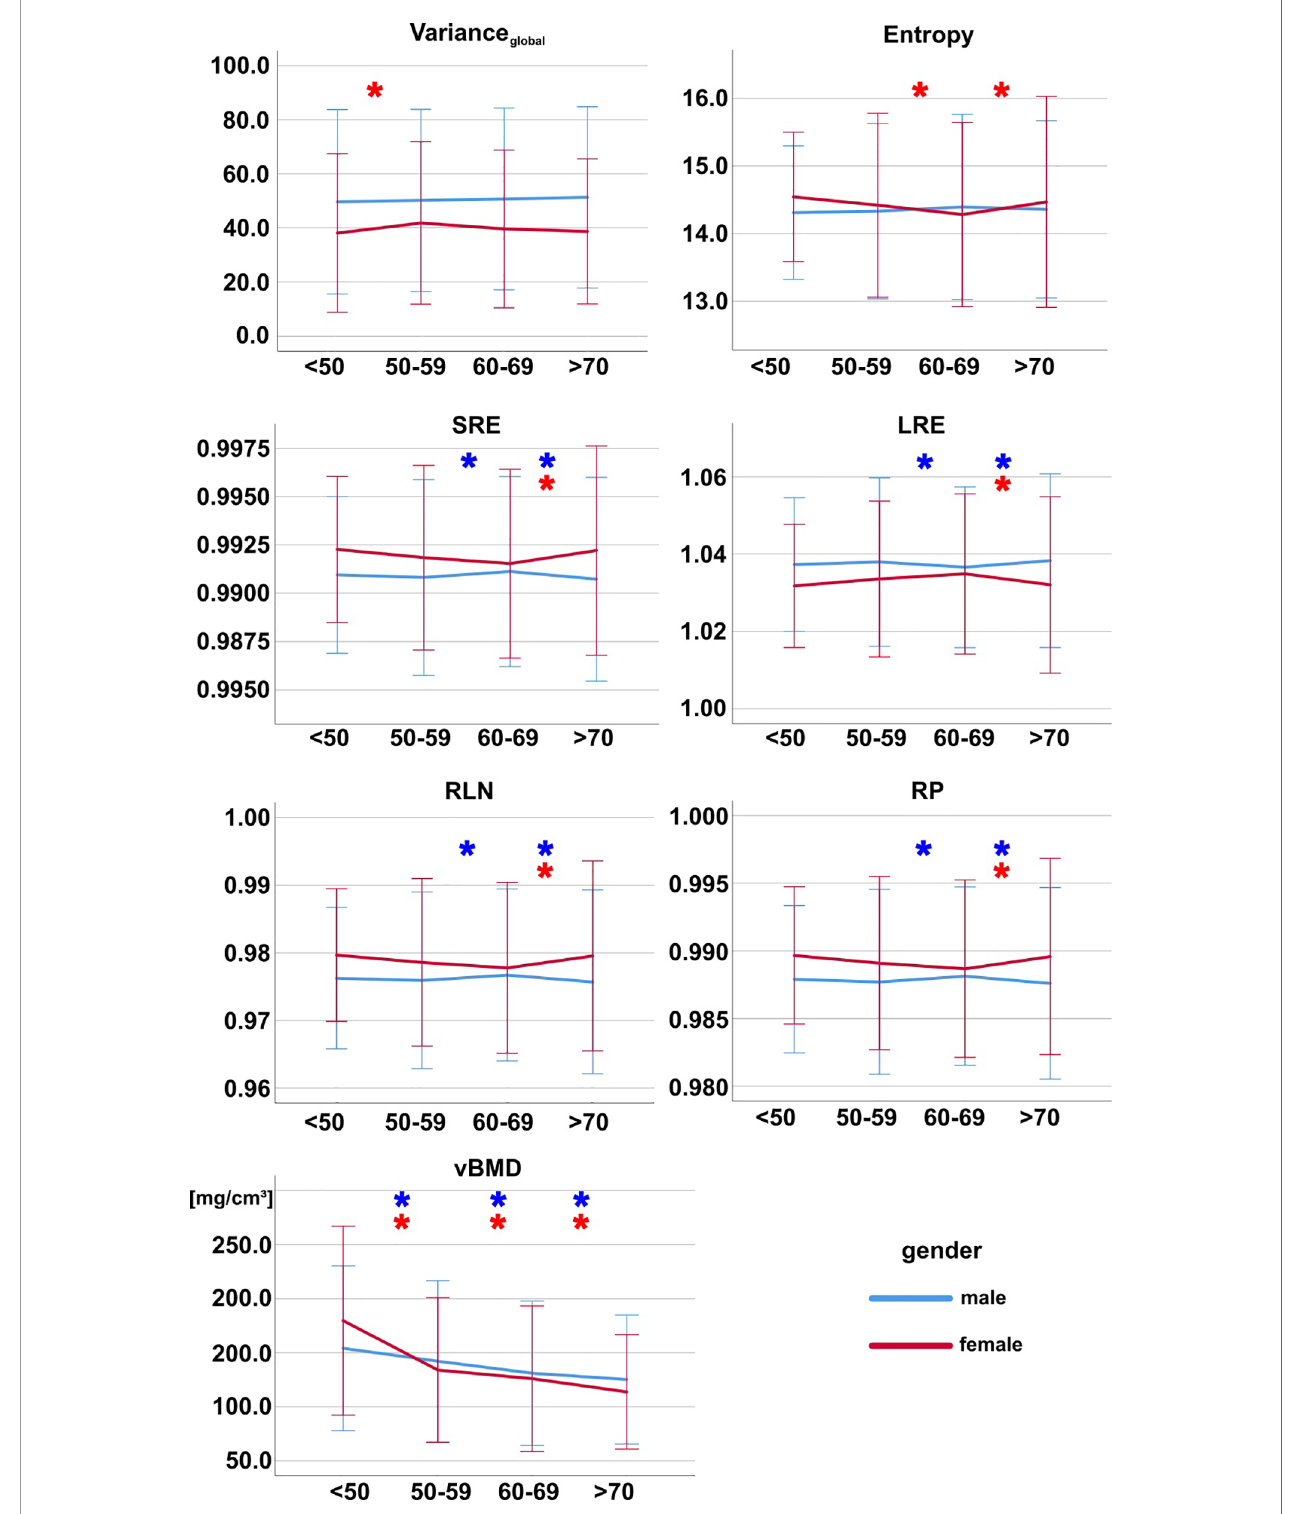
FIGURE 4 | Texture features and vBMD grouped by age group for females (red) and males (blue). Asterisks (*) mark pairwise signi fi cant differences between consecutive age groups. Bonferroni correction was applied to adjust for multiple comparisons. Error bars indicate ± 2 standard deviations. SRE, short-run emphasis; LRE, long-run emphasis; RLN, run-length non-uniformity; RP, run percentage; vBMD, volumetric bone mineral